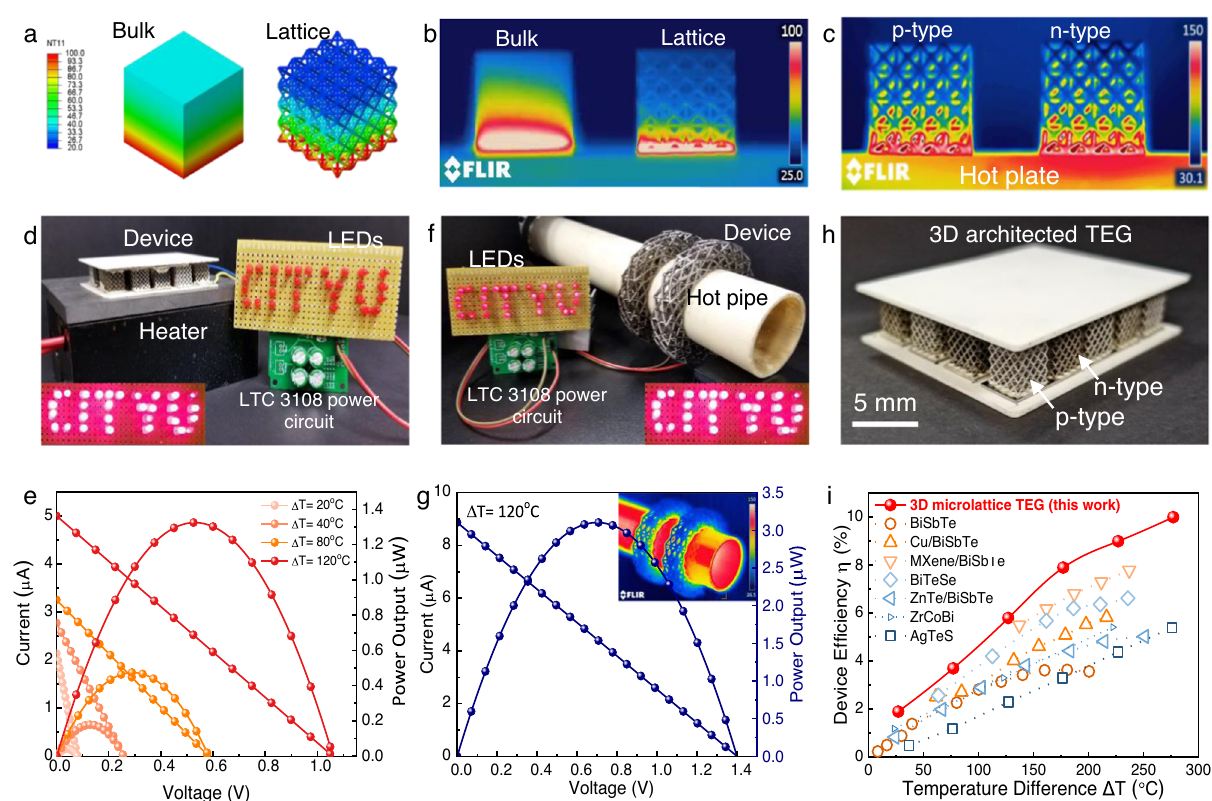
Fig. 4 | Real-time applications of 3D architected TEGs. a Heat transfer model of the conventional solid TEG legs and microlattice TEG legs, showing the reduced effective thermal conductivity of the microlattice legs compared to monolithic legs. b IRimageofthesolidandarchitectedTEGlegsverifyingthesimulatedmodel. c IR image of the p-type and n-type architected TEG legs under operating condi- tions. d , e Demonstrating the ability of the developed 3D architected TEGs (planar and circular) to conform to any desired surface and power electronic circuits